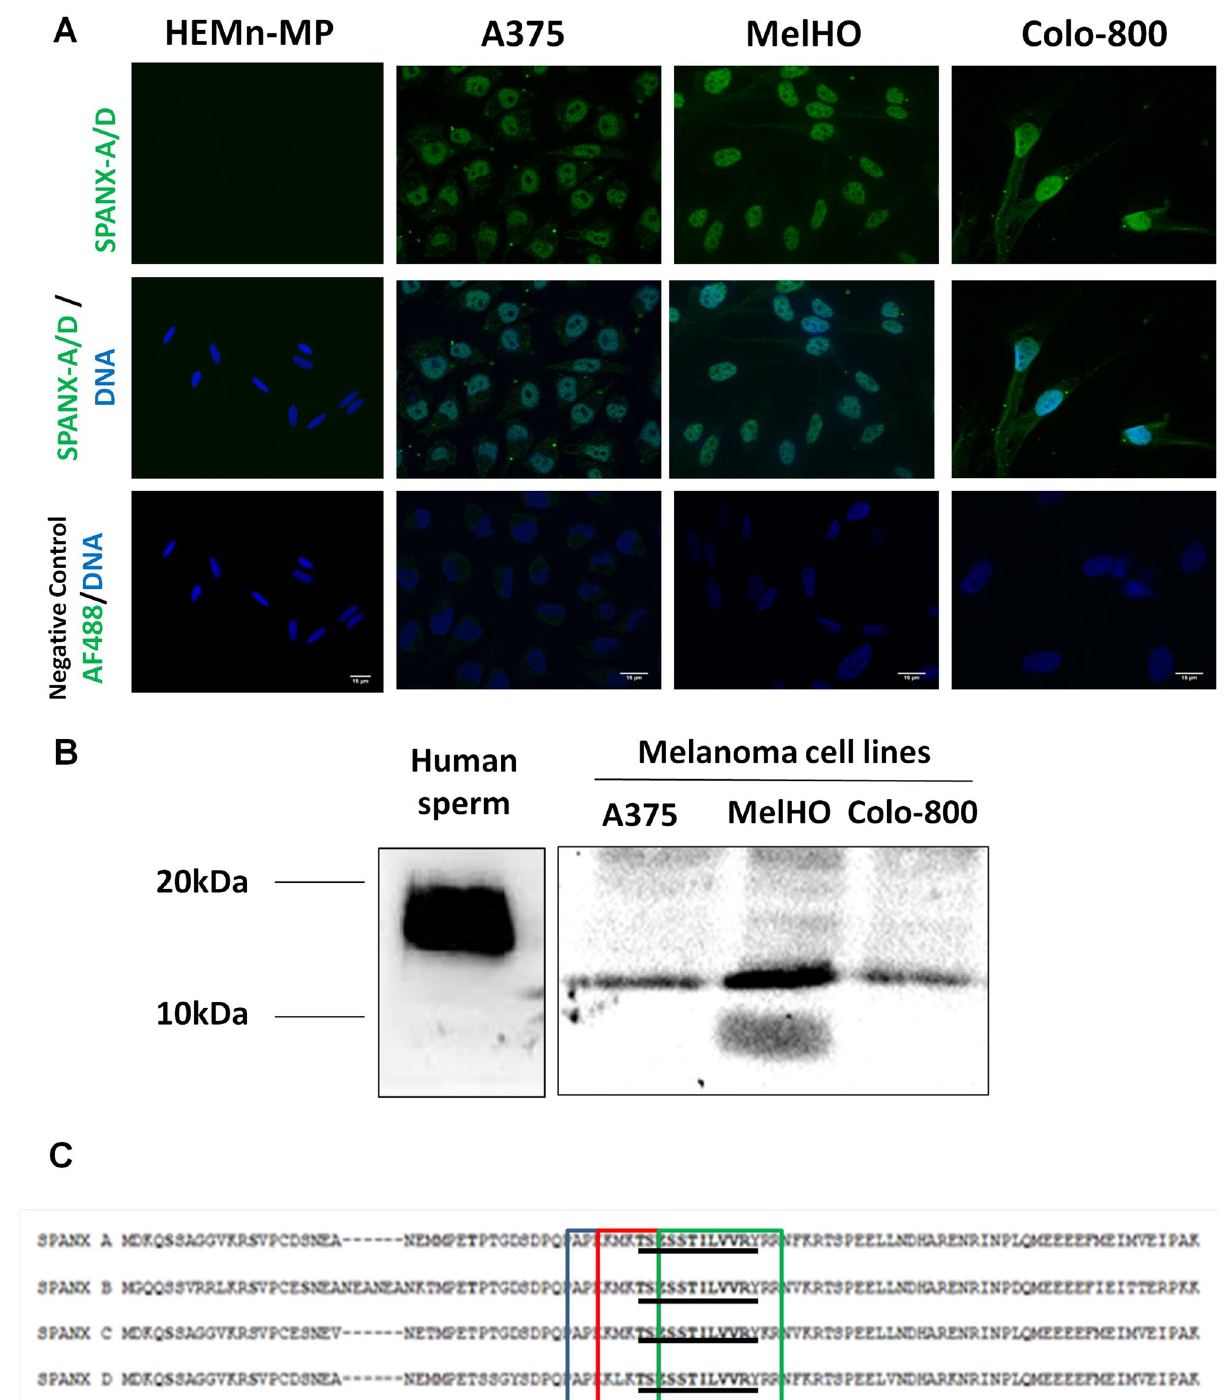
Figure 1. Characterisation of SPANX-A/D protein family in human melanoma cancer cells. (A) by immunocytochemistry. A375, MelHO and Colo-800 human melanoma cancer cell lines were used. As negative control cells HEMn-MP melanocytes were used. For the specificity of the secondary antiserum, the primary antibody was omitted. The nuclei were stained with Hoechst and are represented in blue. Scale bar 15 μm. AF488: Alexa Fluor 488 donkey anti-rabbit IgG (Thermo Scientific) (N = 4). Images were evaluated using ImageJ software (1.48v) (B) by western blotting technique. A375, MelHO and Colo-800 human melanoma cancer cell lines were used. Human sperm lysate was used as positive control. (N = 3). Crop from Supplementary Fig. S2. (C) Comparison of each SPANX isoform sequences with the three overlapping consensus nuclear localisation signals remarked in shaded boxes. The peptide detected by LC–MS/MS is underlined for all